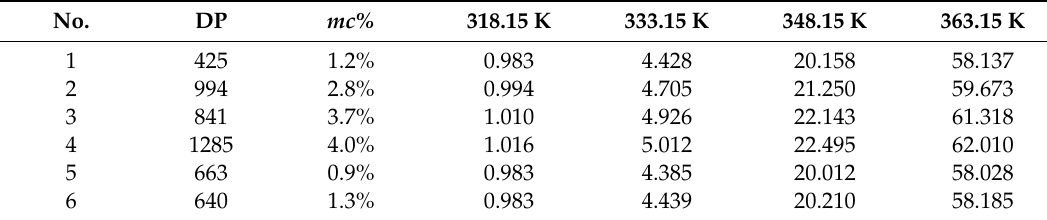
Table 5. The predicted shift factor of various